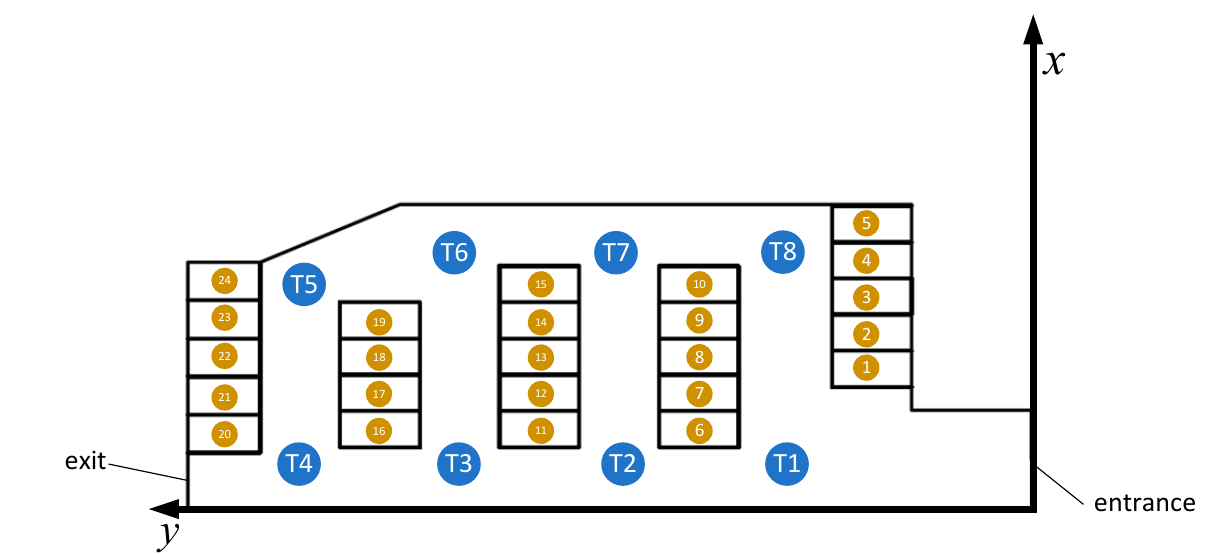
Figure 4. Layout of nodes in the parking lot and reference to a coordinate system.